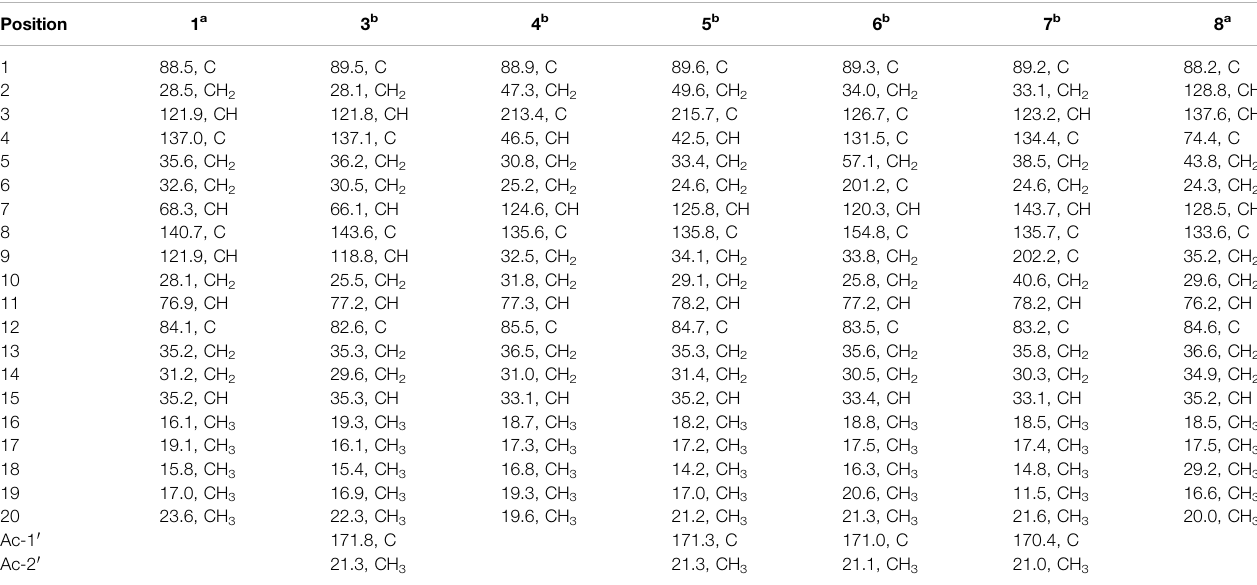
TABLE 2 | 13 C NMR spectroscopic data of compounds 1 , 3 – 8 ( δ in ppm, in CDCl